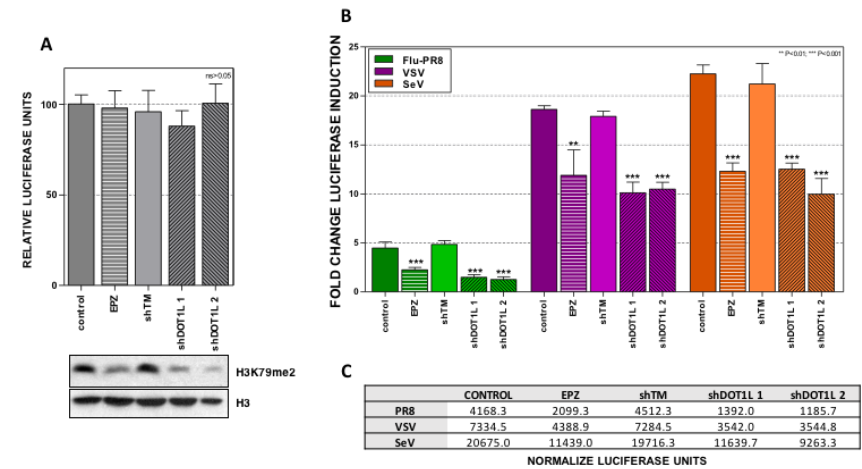
Figure 1. Dot1L inhibition or downregulation decreases IFN- β promoter stimulation in infected cells. ( A ) Upper part: A549 cells were left untreated (control), treated with a Dot1L inhibitor (EPZ, 1 μ M, 48 h) or infected with lentiviruses expressing an irrelevant shRNA (shTM) or specific Dot1L shRNAs (shDOT1L 1 and shDOT1L 2) for 5 days. The cells were then transfected with plasmid pIF-LukTer and the luciferase activity was evaluated 16 h later. The luciferase activity was normalized by Renilla luciferase and the value obtained in the control cells was set as 100%. Lower part: Total extracts were used for Western blot analysis against the indicated proteins. ( B ) A549 cells were left untreated (control), treated with Dot1L inhibitor (EPZ, 1 µ M, 48 h), or infected with lentiviruses expressing the indicated shRNAs for 5 days. The cells were then transfected with plasmid pIF-LuKter and 24 h later they were infected with influenza (FLU-PR8), or Sendai (SeV), or vesicular stomatitis virus (VSV) at MOI of 1. The luciferase activity was measured at 16 hpi and it is shown as the fold change relative to the levels in each control condition after normalization with the Renilla luciferase levels in each sample. The relative luciferase units obtained in each condition are represented in the lower part. Three technical replicates of three independent experiments were analyzed. ns p > 0.05; * p < 0.05; ** p < 0.01; *** p < 0.001.